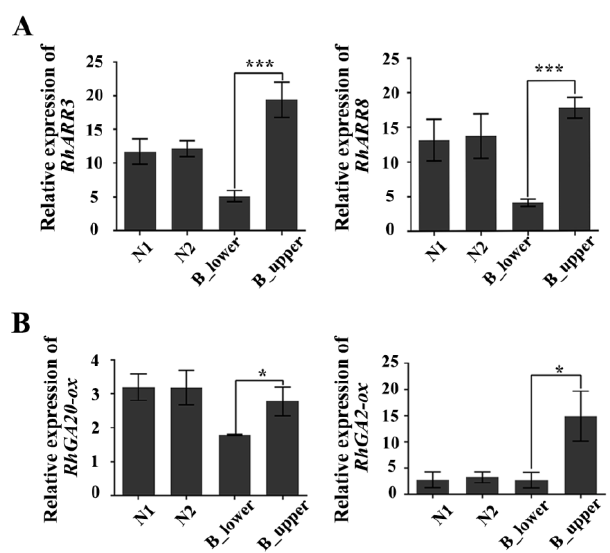
Figure 6. qRT-PCR of cytokinin- and gibberellin-related genes in BP. ( A ) Cytokinin-response genes RhARR3 and RhARR8 . ( B ) Gibberellin-synthesis-related genes RhGA20-ox and RhGA2-ox . Error bars represent SD. Three biological replicates were used. Asterisks denote statistically significant differences determined by using Student’s t -test (* p < 0.05, *** p < 0.001).